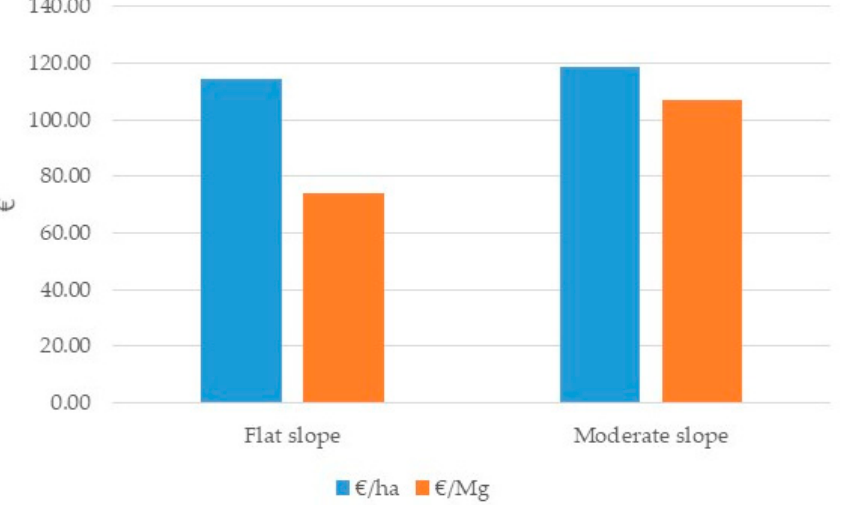
Figure 3. Harvesting cost for FS and MS in terms of cost per surface unit and cost of biomass unit.